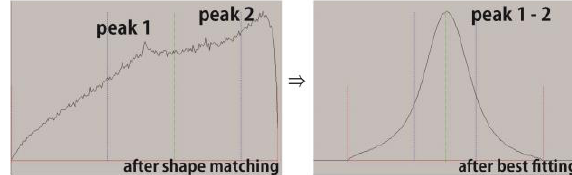
Figure 1: The Example of Histgrams of error distributions (PolyWorks IMAlign was